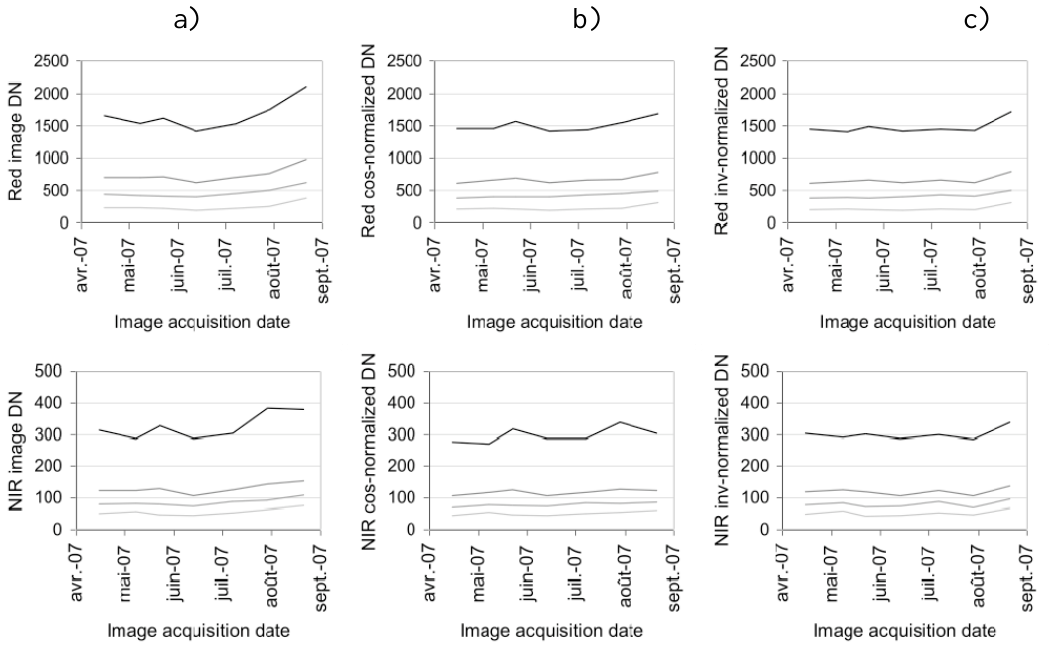
Figure 12. Radiometric values (DN) of artificial invariant target signals in the Red and Near Infrared bands. Comparison of (a) uncorrected values, (b) cosine-corrected values and (c) invariant-corrected